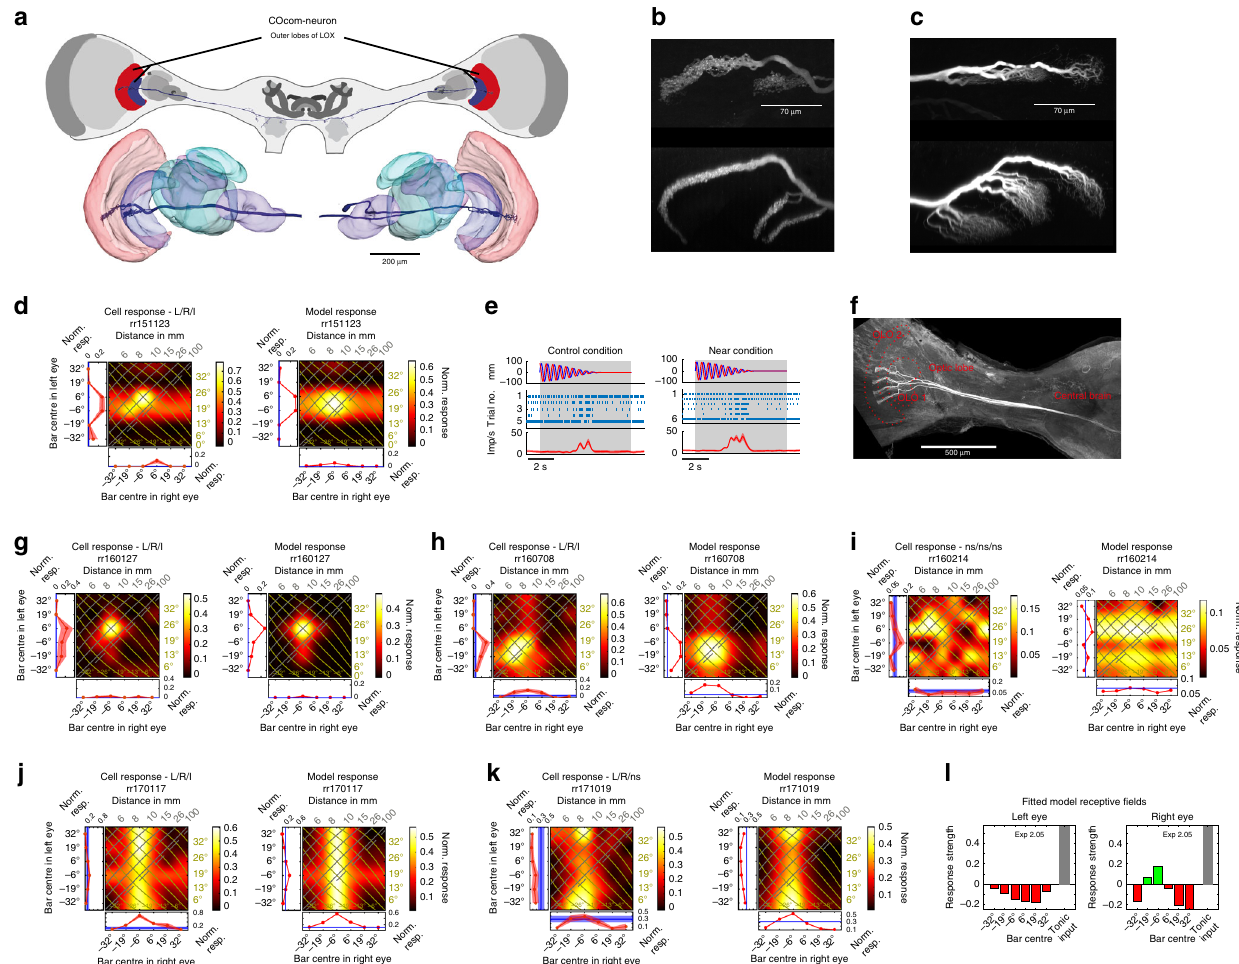
Fig. 3 Columnar, commissural neuron, connecting both lobula complexes. a COcom-neuron (columnar commissural neuron of the outer lobes) reconstruction, anterior view. Neuron rami fi es in outer lobes of both LOX and in central brain. b , c Maximum projections of confocal horizontal (posterior to anterior orientation; top) and frontal sections (dorsal to ventral orientation; bottom) through outer lobe 1 and 2 in right ( b ) and left ( c ) optic lobe. Terminal neurites are strongly beaded in right ( b ) and smoother in left optic lobe ( c ). d Measured (left) and modelled (right) response fi elds for neuron in ( a , b , c ) for fl ashed dark bars. e response of same neuron to spiralling disc. f Maximum projection of confocal microscopy slices through left side of praying mantis brain (posterior view), showing several COcom-neurons stained during the experiment that culminated in the recording of neuron rr170117 (response in j). OLO1 outer lobe 1 of LOX, OLO2 outer lobe 2 of LOX. g – k as d for fi ve further COcom-neurons (see Supplementary Fig. 3 for fi tted receptive fi elds and responses to bright bars for two neurons). Response fi eld headers provide outcome of two-way-ANOVA with “ L ” ( “ R ” ) being signi fi cant left (right) eye input and “ I ” signi fi cant interaction term (see Table 1), otherwise “ ns ” meaning not signi fi cant. l , Fitted receptive fi elds for neuron in ( k